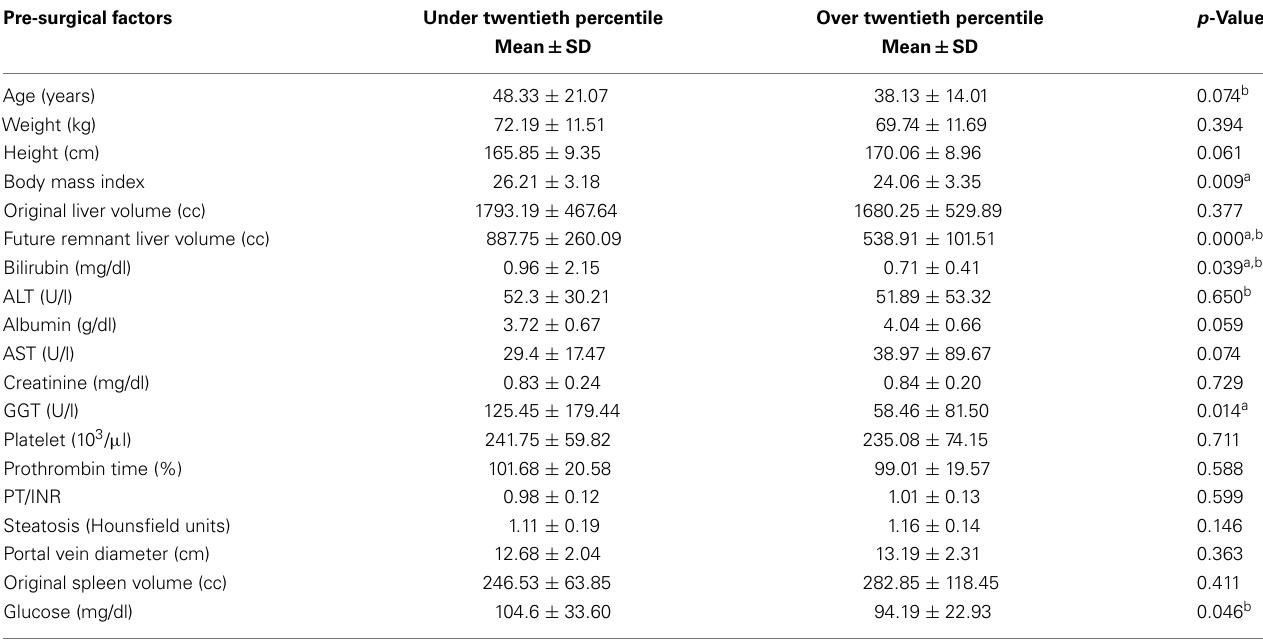
Table 3 | Comparison of risk factors between patients above ( n = 21) and below the twentieth percentile ( n = 79) for and liver regeneration. Pre-surgical factors